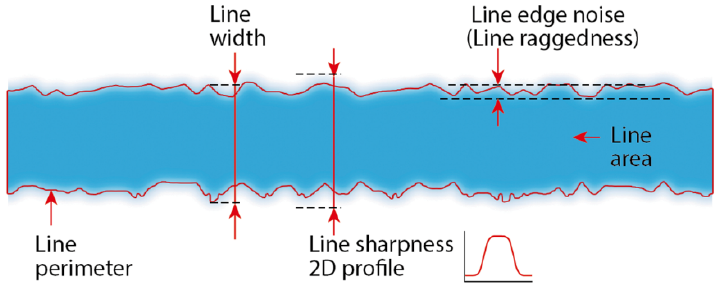
Figure 1. Line print quality